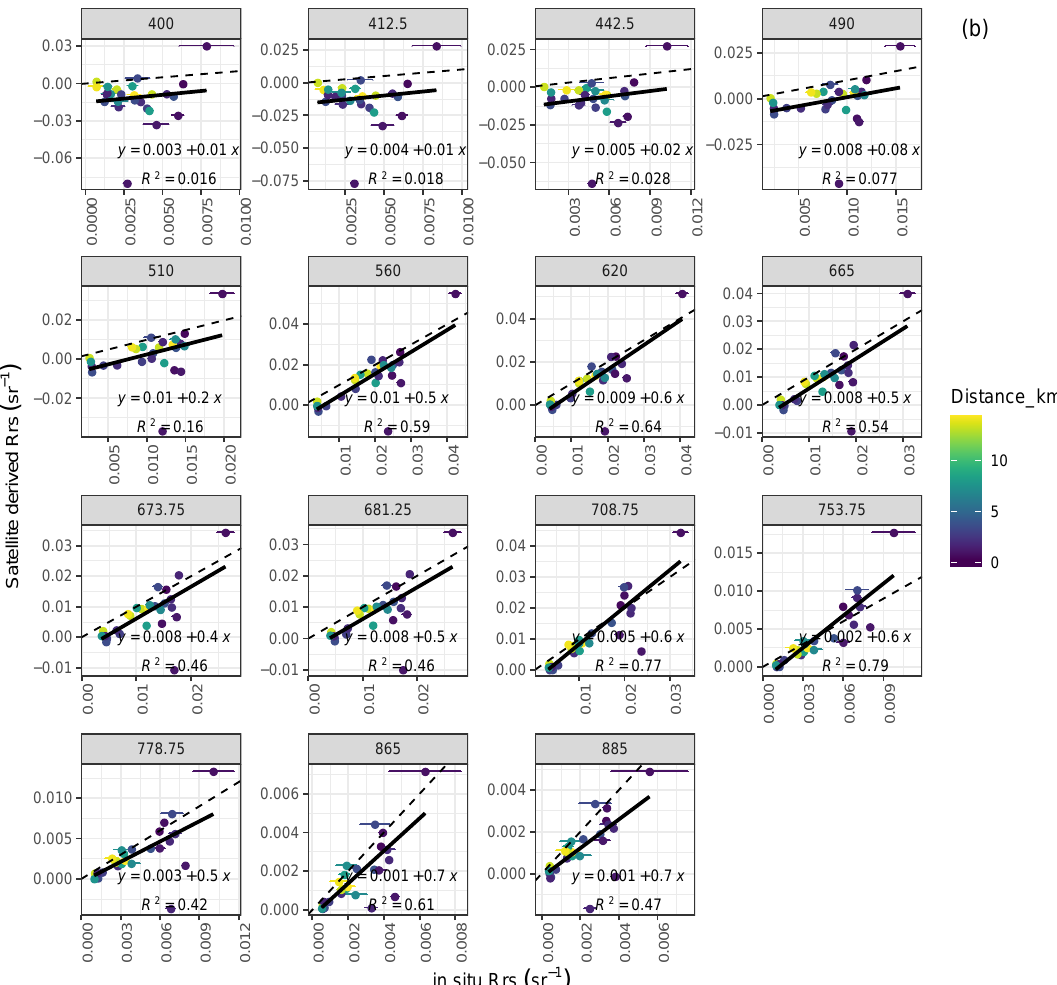
Figure A3. Correlation between in situ measured ( x -axis) vs. standard L2-derived rho ( y -axis) on OLCI bands. Upper figure ( a ) shows validation results on all data and lower ( b ) after filtering the in situ data based on the 5% criteria at least in one band. For each match-up point, the color shows the distance from the